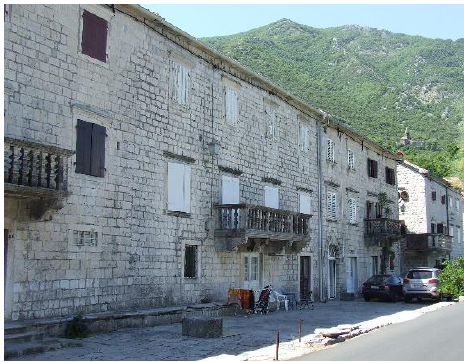
Figure 10. A row of houses in Prčanj and Muo.